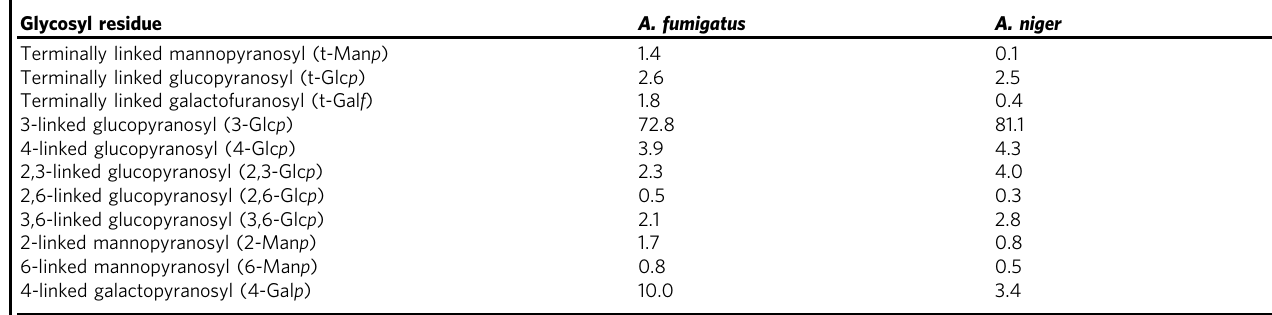
Table 1 13 C-glycosyl linkages of fungal neutral sugars Glycosyl